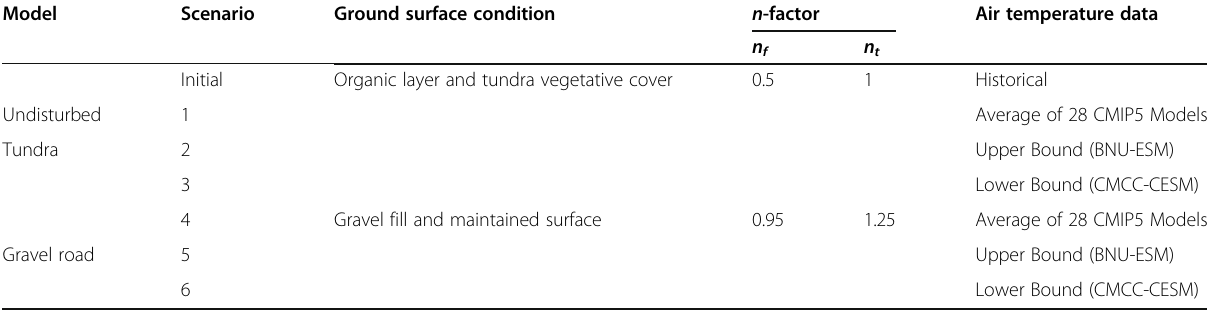
Table 3 TEMP/W model iterations in this study